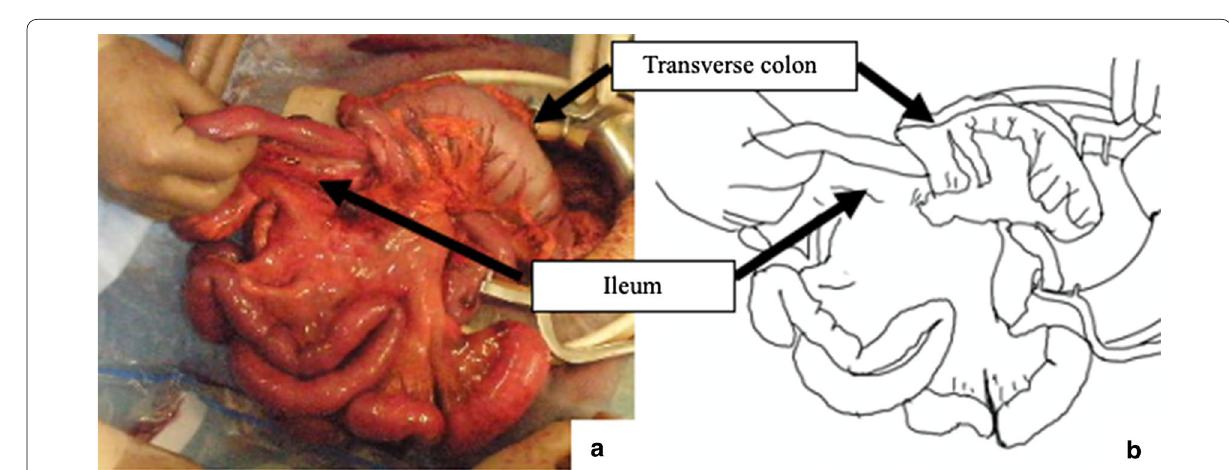
Fig. 4 Intraoperative view. Ascending colon and cecum are invaginated in the transverse colon with the mobile cecum. a Intraoperative photograph. b Schematic representation